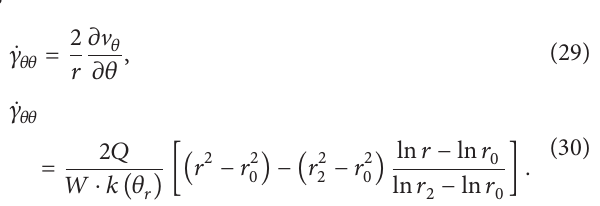
Figure 7: The circumferential tensile strain rate of melt moving in a chamber of VCPU: discharge